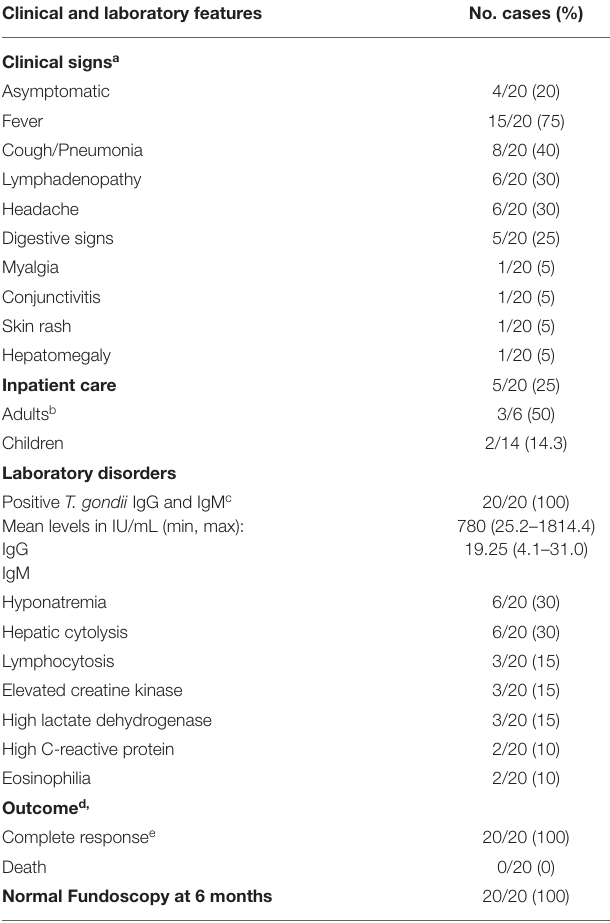
TABLE 2 | Clinical and laboratory features of the 20 cases of acute toxoplasmosis, Camopi, French Guiana. Clinical and laboratory features